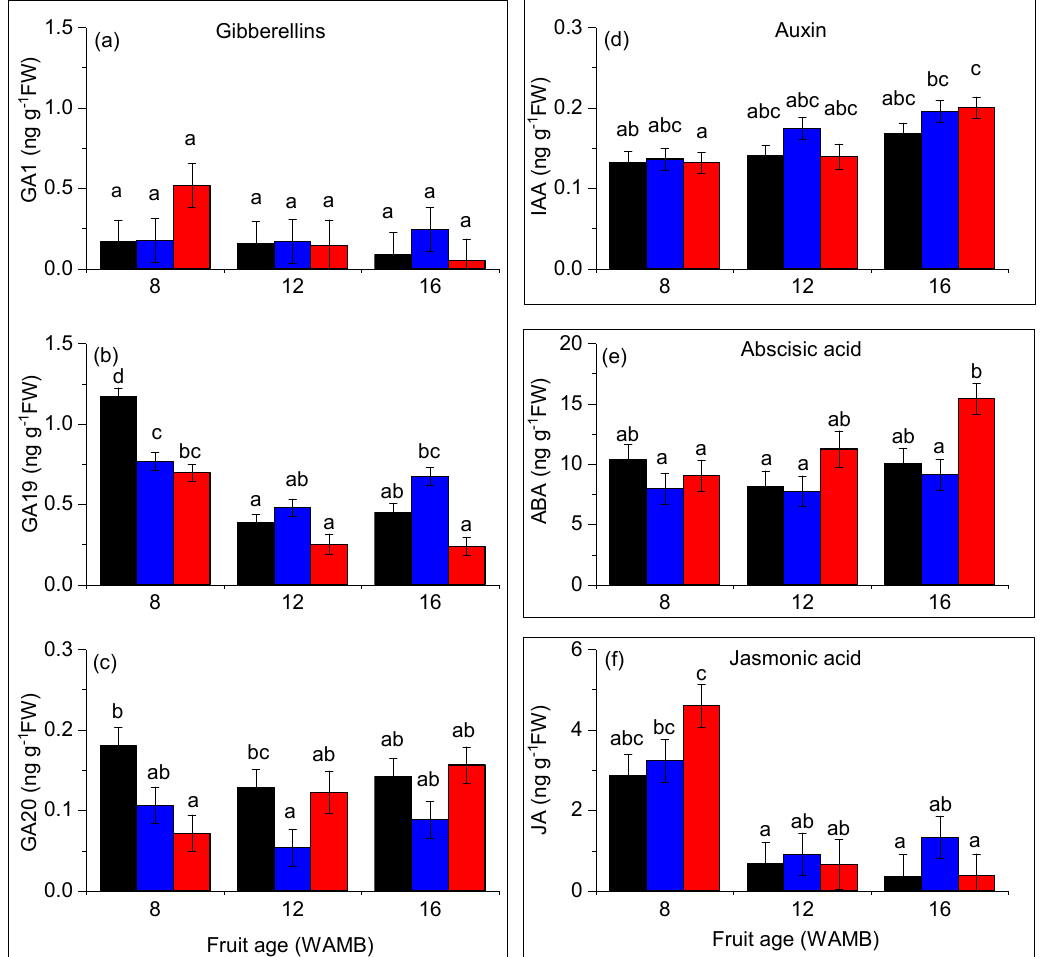
Figure 4. Gibberellins, auxin, abscisic acid, and jasmonic acid concentrations in the outer pericarp of developing kiwifruit: ( a ) GA1, gibberellin A1; ( b ) GA19, gibberellin A19; ( c ) GA20, gibberellin A20; ( d ) IAA, indole-3-acetic acid; ( e ) ABA, abscisic acid; ( f ) JA, jasmonic acid.. Untreated control (black bar; vine standard), low carbohydrate supply (carbon starvation; blue bar), and high carbohydrate supply (red bar). Values are averages ± SEM ( n = 4). Statistical analysis by linear mixed effects model with type 3 sums of squares Kenward–Roger’s method; different letters mean a statistical difference, adjusted for multiple comparison by Tukey’s correction ( p < 0.05). Fruit age is in weeks after mid bloom (WAMB). FW, fresh weight.